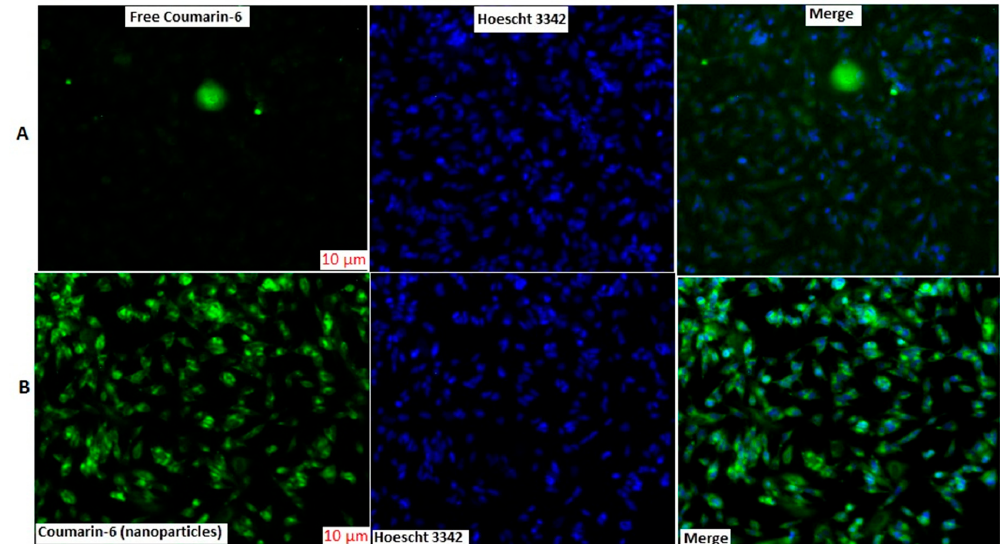
Figure 6. Fluorescence microscopy images of cellular uptake of coumarin-6 NPs and coumarin-6 solution in SH-SY5Y cells. The scale bar for ( A , B) is 10 µ